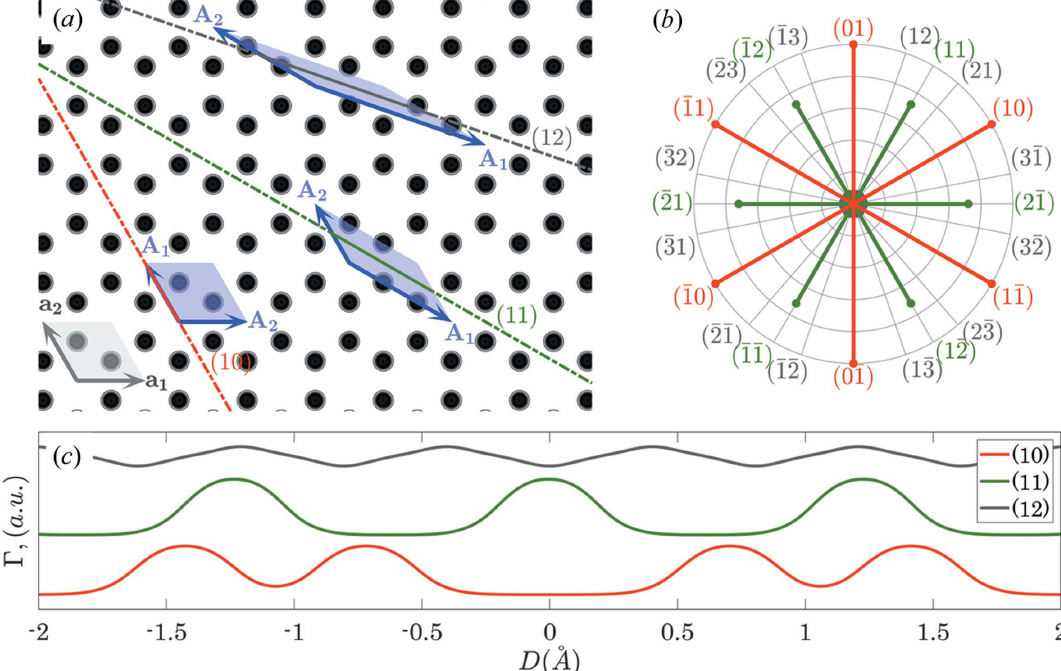
Figure 2 A two-dimensional illustration of the GALOCS output for the case of graphene. ( a ) The SFF for the structure of graphene according to equation (1) and electron densities of isolated carbon atoms. The same figure shows the standard unit cell and its three transformations, suitable for the analysis of the corresponding planar gaps in this structure. In all cases, the transformed unit cell has the vector A 1 parallel to the ( hk ) planes. ( b ) The dependence of the C hk on the direction n k B hk . The Miller indices corresponding to each of the directions are marked explicitly. ( c ) The dependences of (cid:2) (10, X 3 ), (cid:2) (11, X 3 ) and (cid:2) (12, X 3 ) on D = d hk X 3 (vertically shifted relatively to each other for